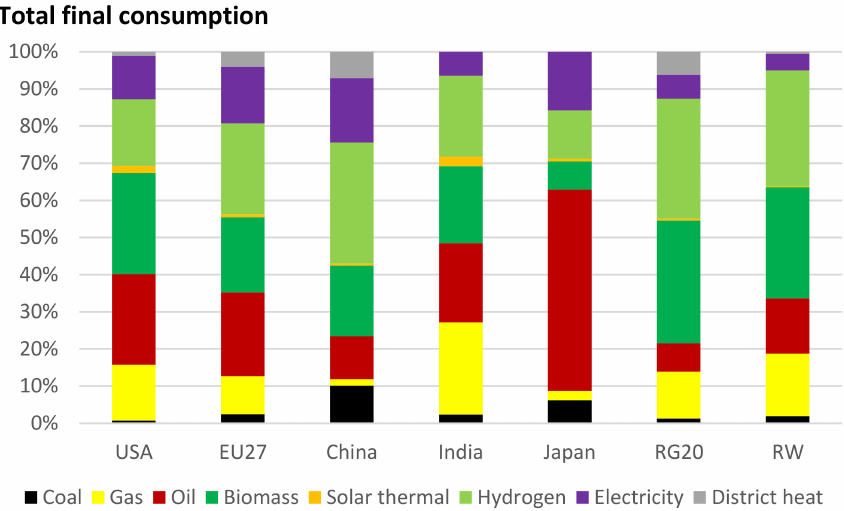
Figure 11. Breakdown of the estimated total final consumption by country/region in the 1.5 ◦ C case, 2050. Note: RG20 = rest of G20; RW = rest of the